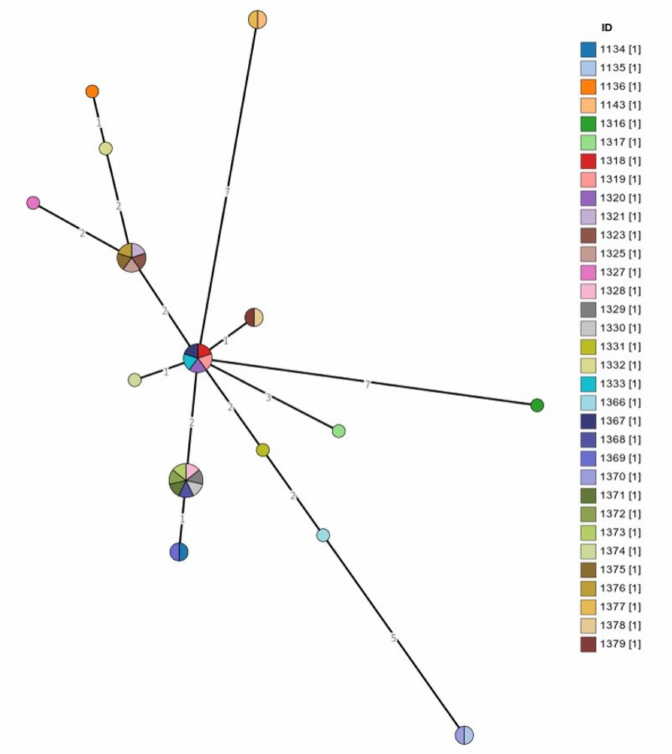
Figure 5. MLST-based spanning tree of 33 S. epidermidis isolates from cases of ovine mastitis in Greece in the MLST database according to isolate identity (drawn by using the Grape-Tree application). Each colour corresponds to an ST, the number in brackets corresponds to the number of isolates distributed into that ST, the colour of each node corresponds to the ST included in it and the number within the edges (i.e., branches) indicates the allelic distance. MLST: multi-locus sequence typing; ID: isolate identity in the MLST database.